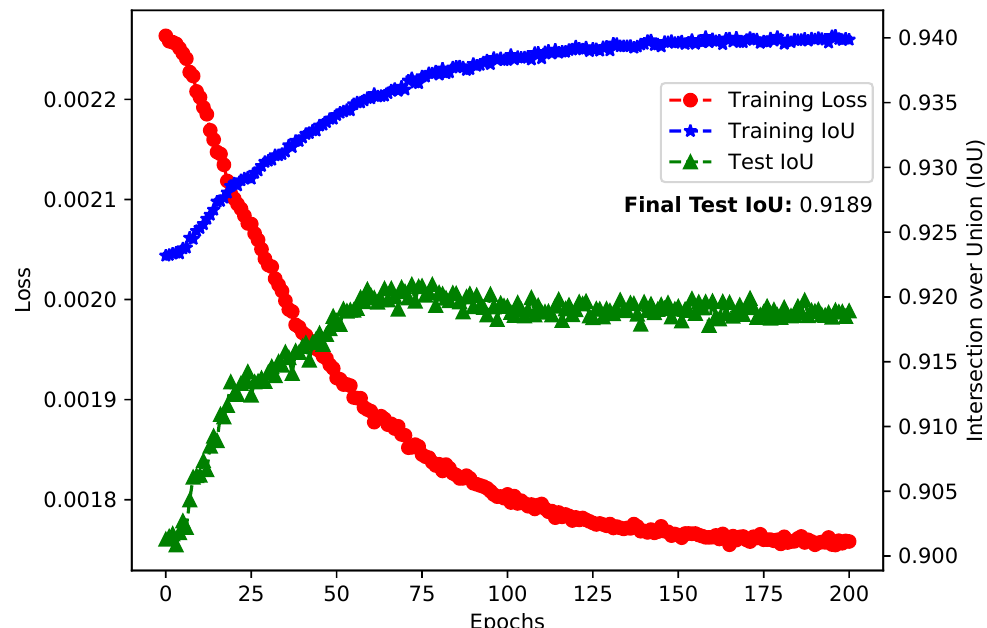
Figure 15. Retraining results of the best ResNet101 model with 512 MB of memory footprint on the São Carlos Rivers dataset.